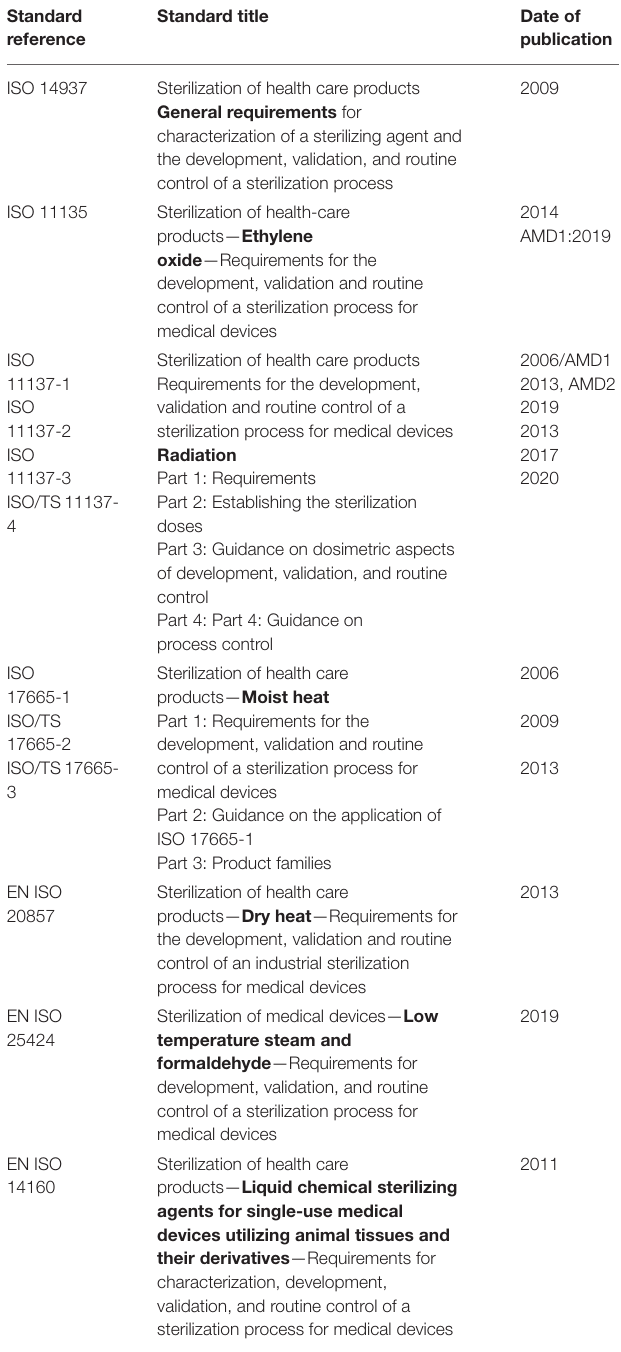
TABLE 1 | Standards for validation and routine control of sterilization